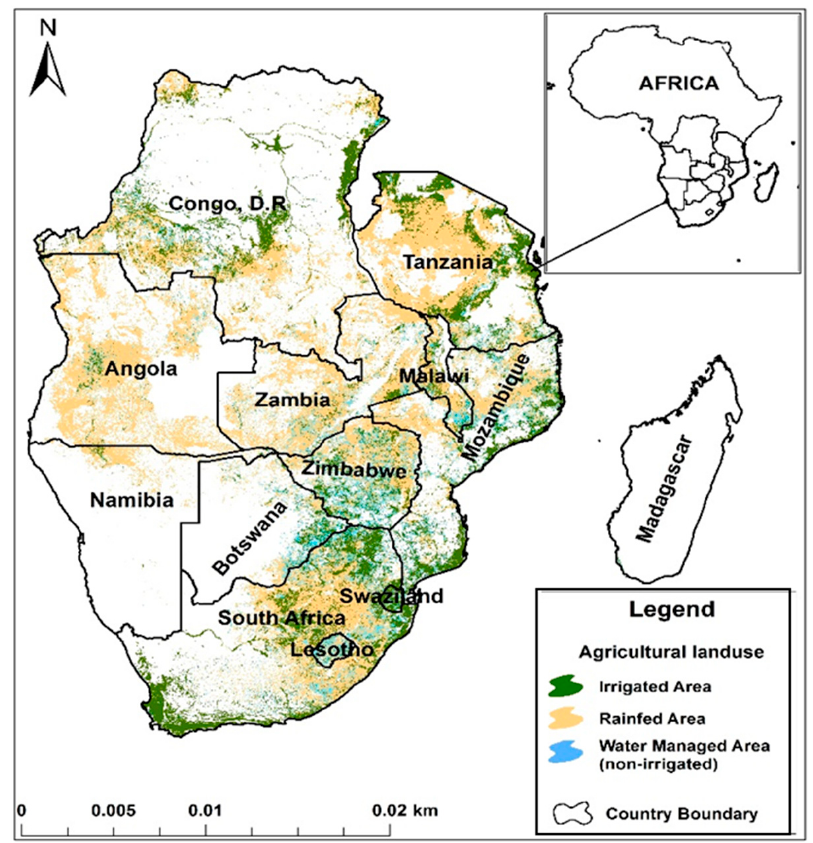
Figure 1. Locational map of southern Africa showing the distribution of agricultural systems. Cultivation is concentrated to countries in the east, whereas to the west, Botswana and Namibia have the least cultivated land due to arid conditions. Source: Adapted from International Water Management Institute (IWMI) irrigated area mapping (IWMI, 2010).